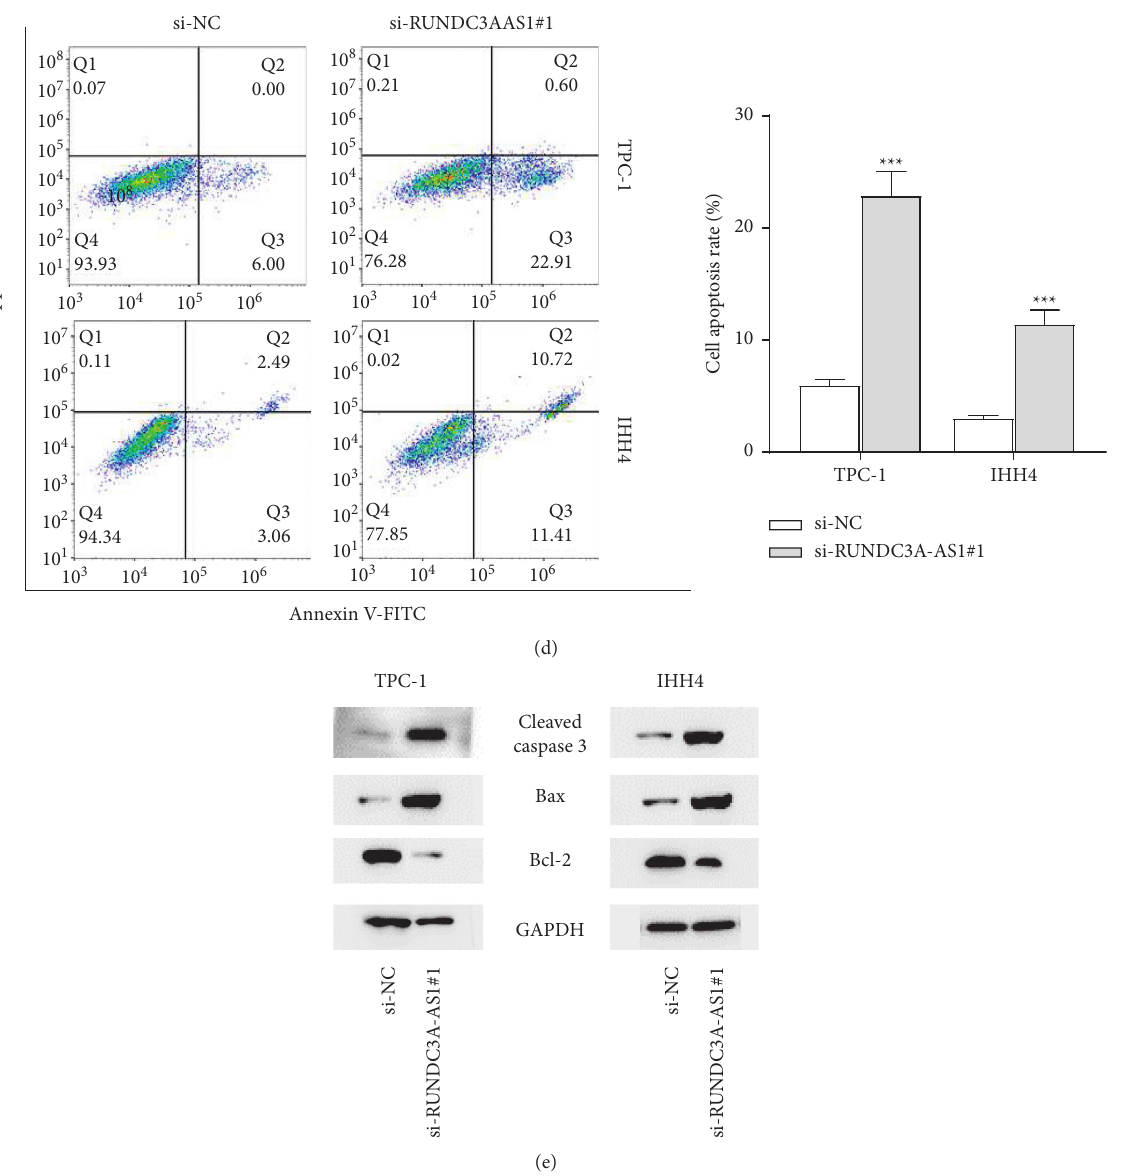
Figure 2: Interfering RUNDC3A-AS1 inhibits cell proliferation and promotes cell apoptosis. (a) The knockdown efficiency of RUNDC3A- AS1 was examined by RT-qPCR. (b) Cell proliferation was examined by the CCK-8 assay. (c) The EdU assay was conducted to detect cell proliferation. (d) THCA cell apoptosis was examined by flow cytometry. (e) Apoptosis-related protein level was examined by western blot analysis. ∗∗ P < 0 . 01; ∗∗∗ P < 0 .